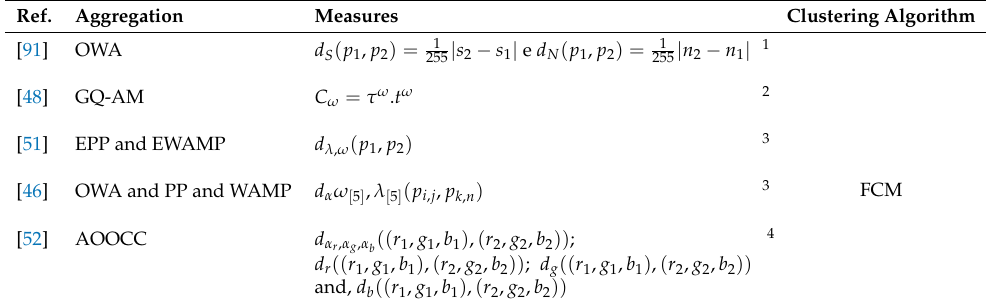
Table 4. Edge detection using clustering and distance functions or fuzzy